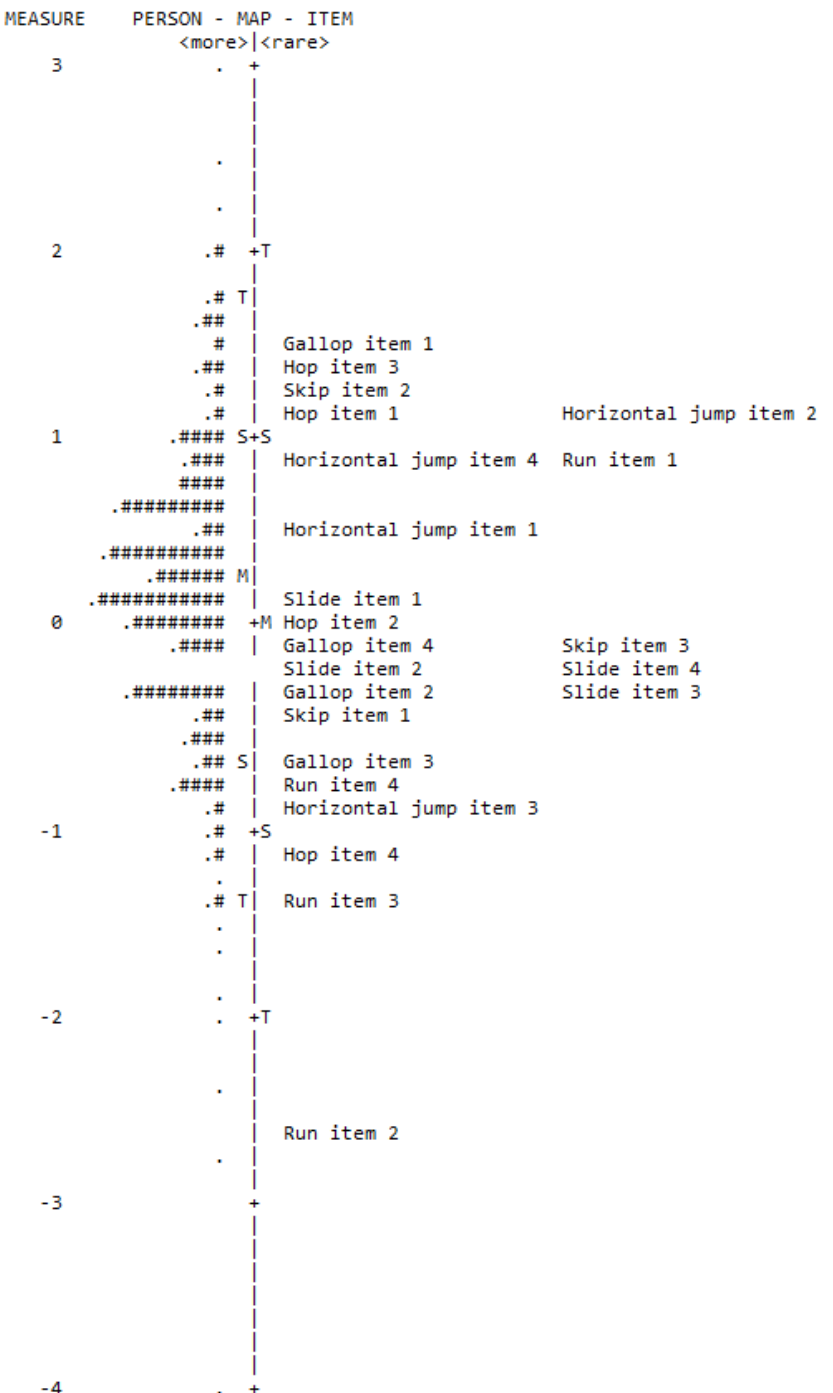
Figure 1. Person-item map: score analysis of the 23 TGMD-3 locomotor skills items. Note: M = mean of person or item distribution; S = one standard deviation from the person or item mean; T = two standard deviations from the person or item mean; # = several persons or items.